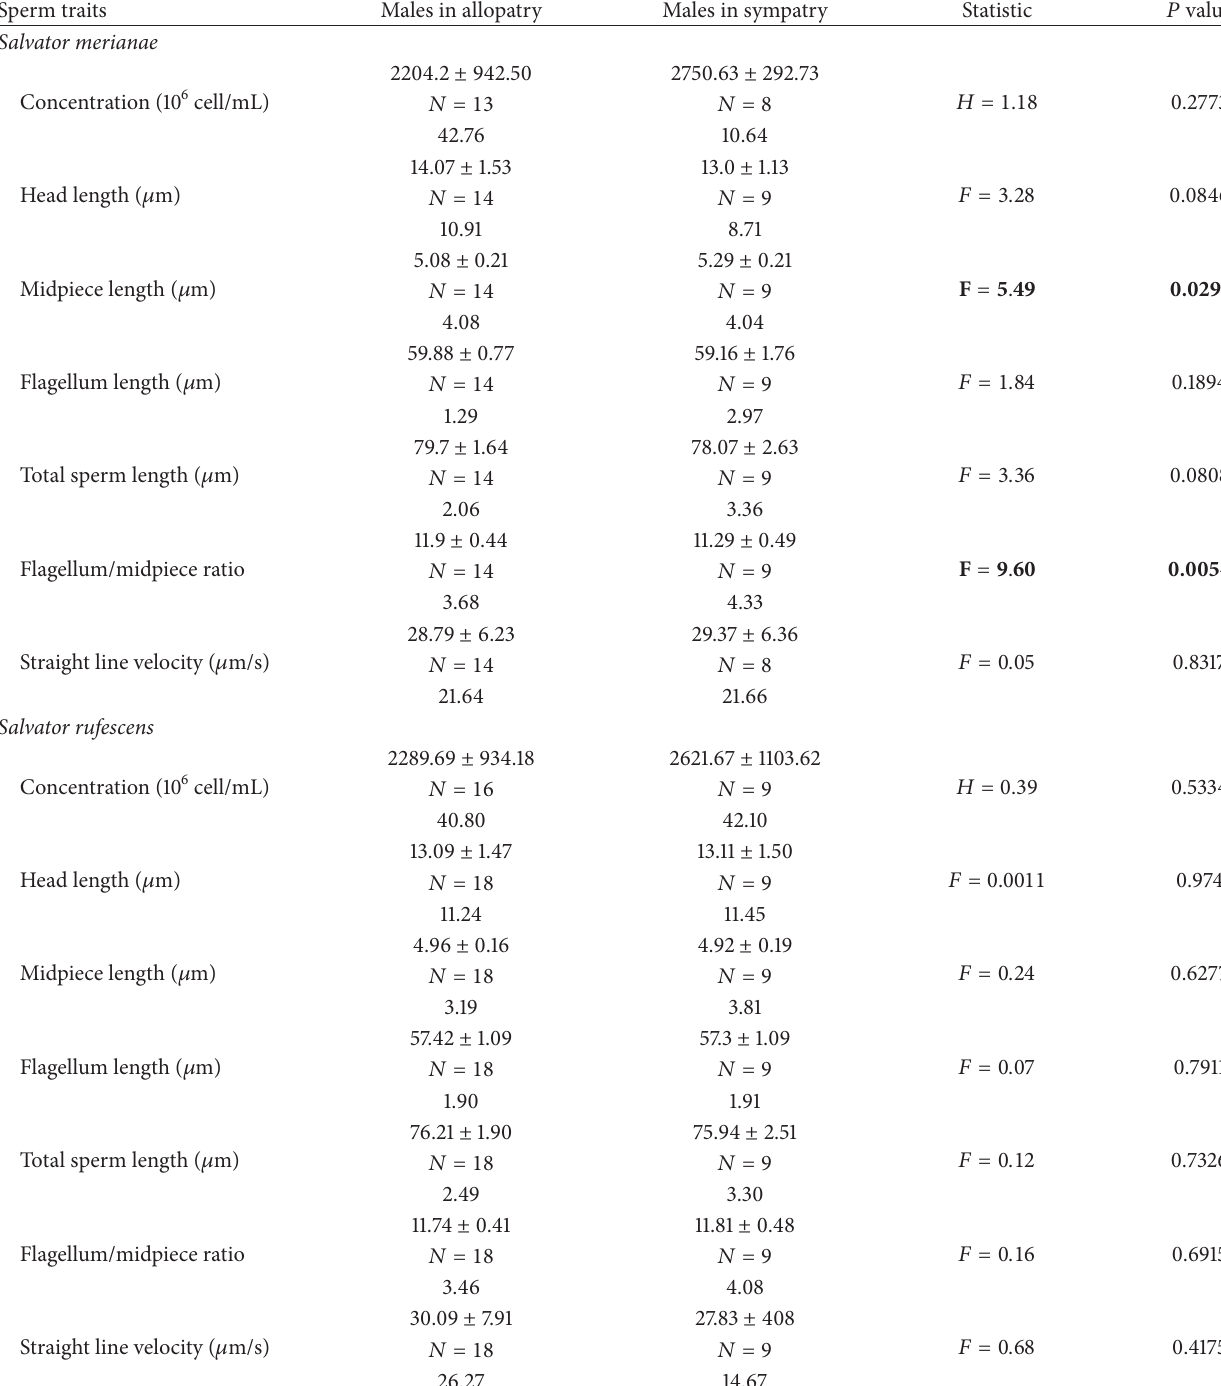
Table 2: Comparison of sperm parameters between social contexts in S. merianae and S. rufescens . Sperm